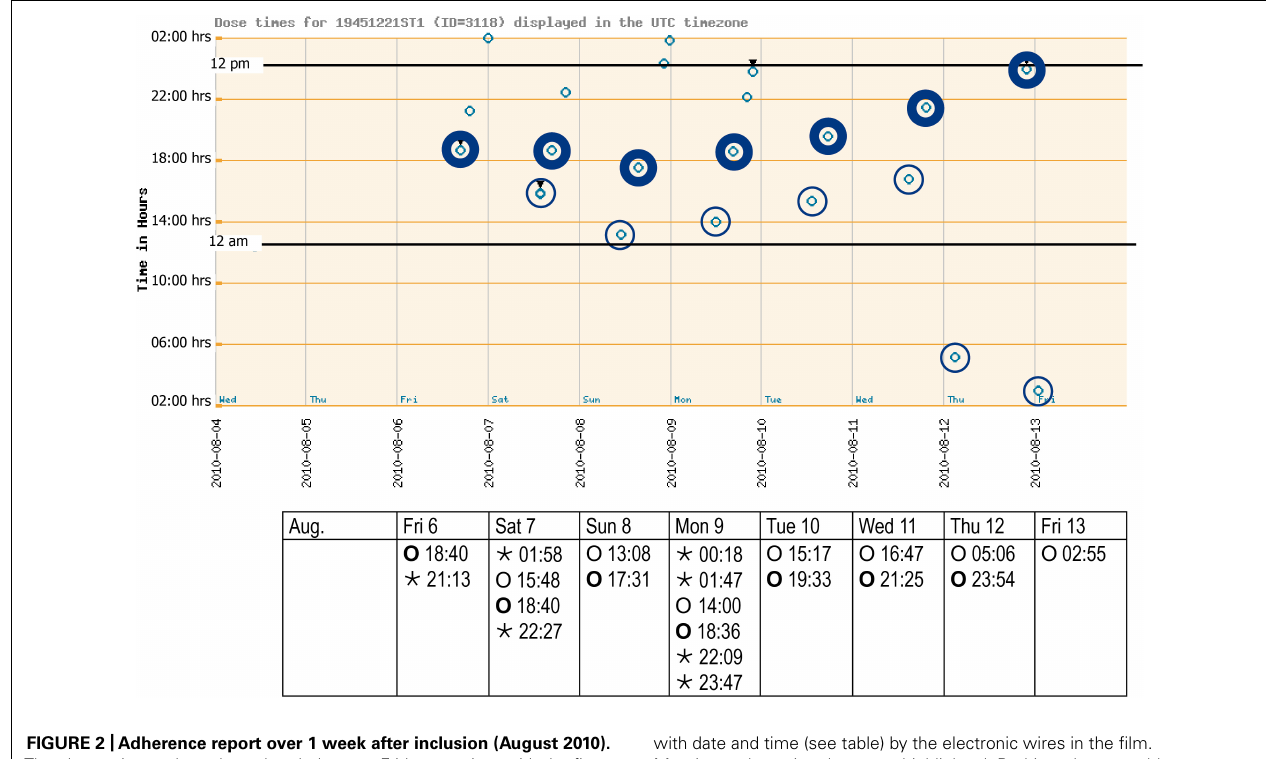
FIGURE 2 |Adherence report over 1 week after inclusion (August 2010). The electronic punch card was handed out on Friday morning, with the first cavity to be opened on the Friday evening.The spots (see graph) reflect a pushing through of all drugs contained in one distinct cavity as recorded